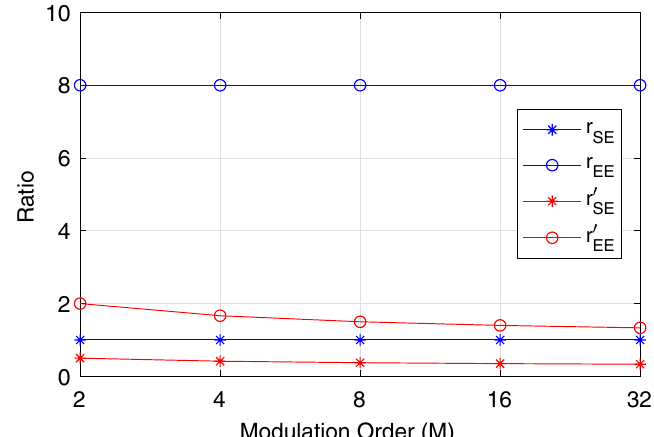
Fig. 7 r SE , r EE , r ′ SE , r ′ EE with different modulation order